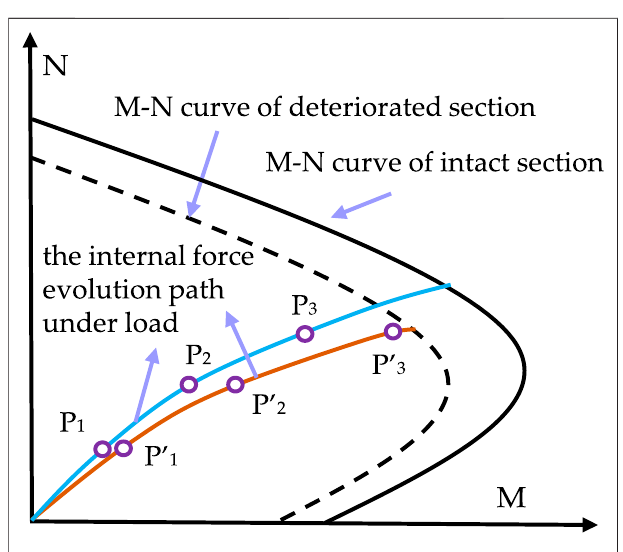
FIGURE 17 | Failure mechanism of the arch structure considering double deterioration